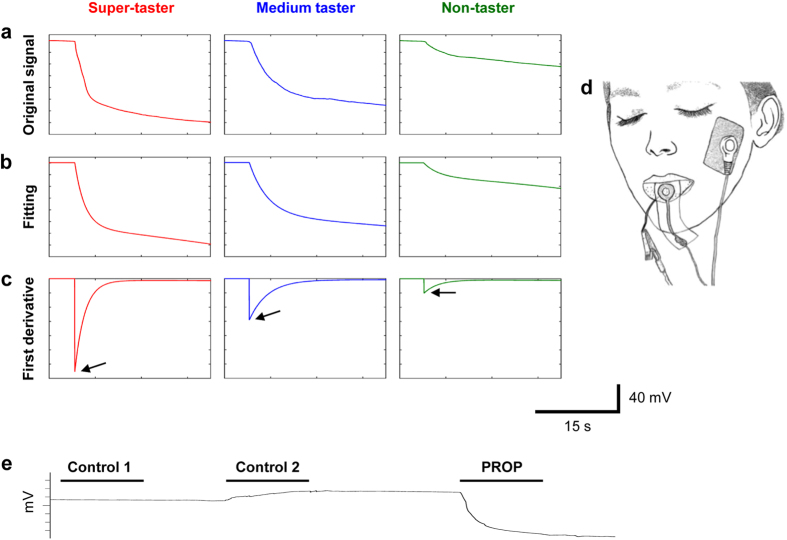
Examples of bio-electrical signals recorded from human tongue, and of waveform analysis.(a) The original signal of a representative super-taster, medium taster and non-taster. (b) The fitting of each original signal applied from the beginning of depolarization up to the next 15 s. (c) The first derivative calculated for each fitting. The maximum value of the first derivative, indicated by an arrow in each panel, was used as an index of depolarization rate of the original signal. The waveform analysis was performed for all participants (n = 43). (d) Drawing showing how electrodes were positioned for the differential electrophysiological recordings: one in contact with the ventral surface of the tongue, and one in perfect adhesion with the dorsal surface; a third disposable adhesive electrode (the ground terminal) was placed on the skin of the subject’s left cheek. This drawing shows that the electrode positioned on the dorsal surface of tongue leaves uncovered a circular area of the tip of the tongue, which was the same area where PROP stimulation was delivered during recordings and the density (No. of fungiform papillae/cm2) of fungiform papillae was calculated. (e) Response example to a sequence of three stimulations (15 s): paper disk (control 1), paper disk impregnated with 30 μl of spring water (control 2), and paper disk impregnated with 30 μl of PROP solution.